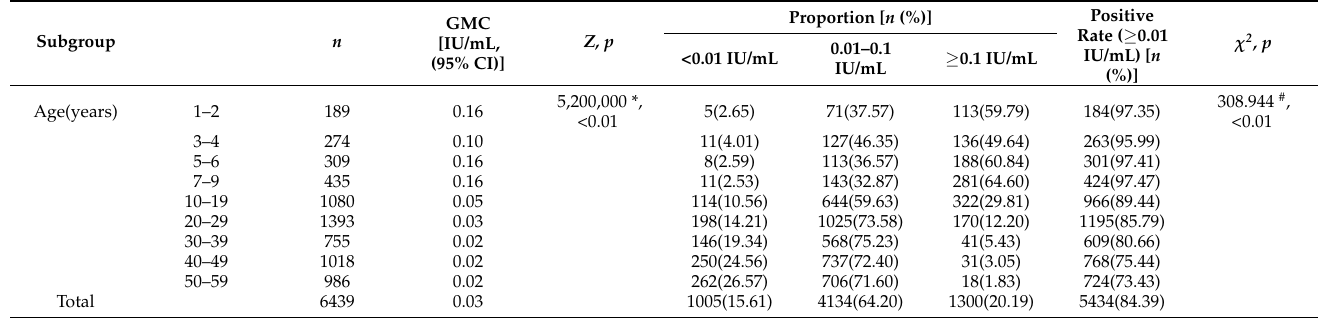
Table 1. Seroprevalence and tetanus antibody level according to age.